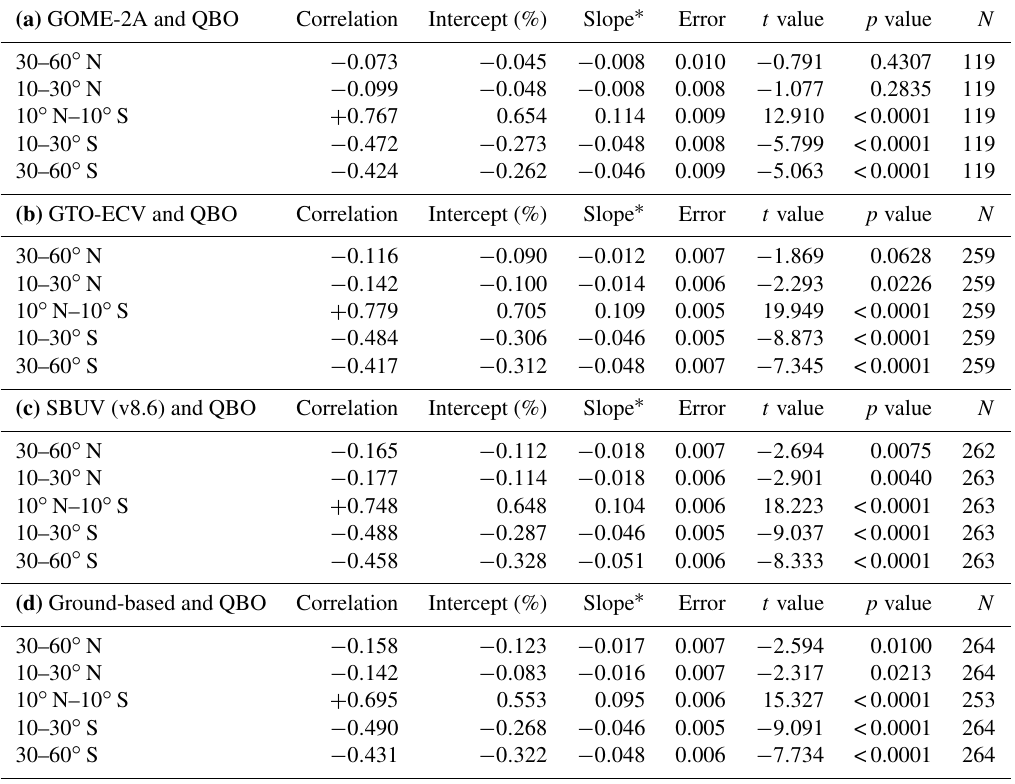
Table 3. Statistics of correlations between deseasonalized total ozone and the QBO at 30hPa for (a) GOME-2A data, (b) GTO-ECV data, (c) SBUV (v8.6) overpass data, and (d) ground-based measurements. (a) GOME-2A and QBO